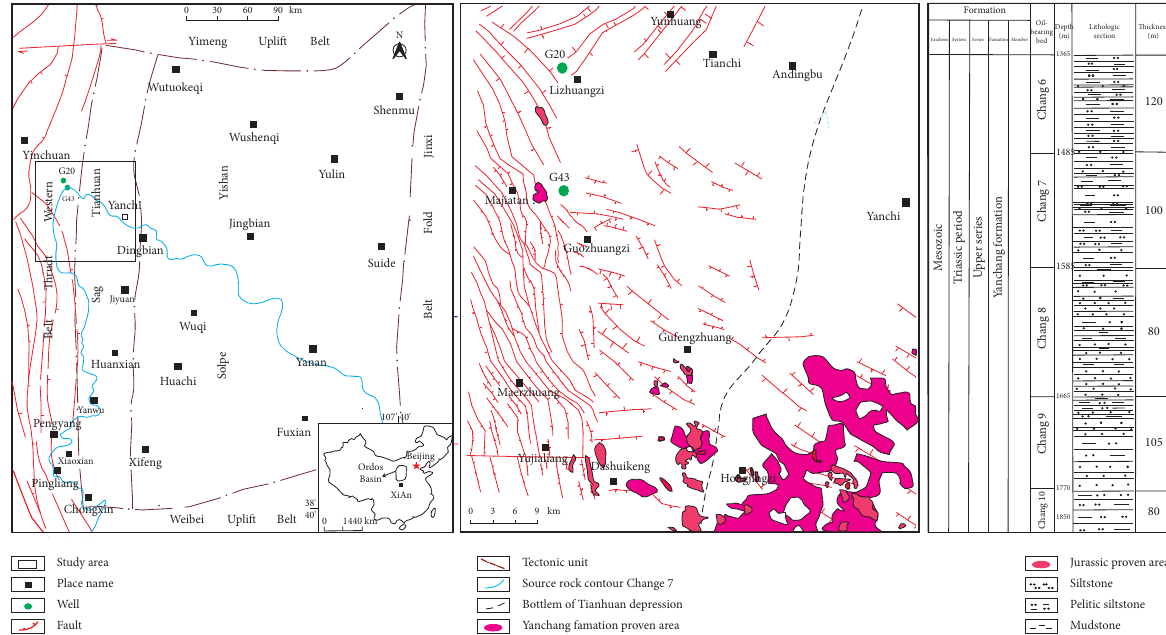
Figure 1: Structural division and stratigraphic distribution in the northwest Ordos